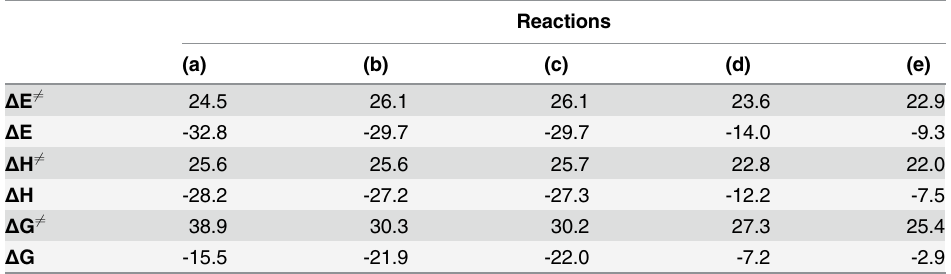
Table 1. Calculated activation and reaction energies for the cycloaddition